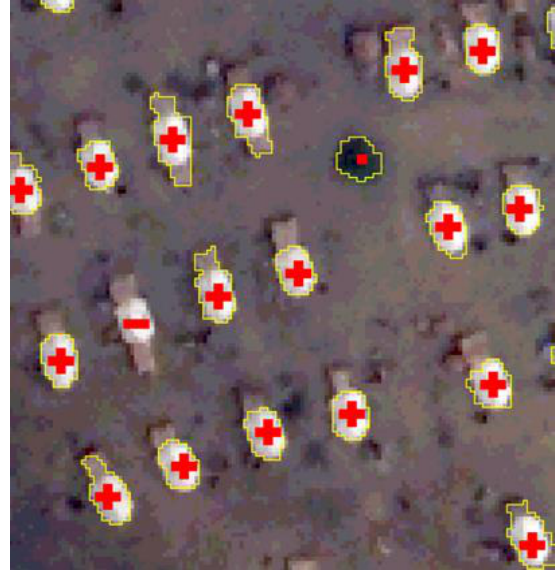
Figure 4 . Subset of the results obtained from the model. The symbols (+), (-) and (.) are true positive (TP), false positive (FP) and false negative (FN)